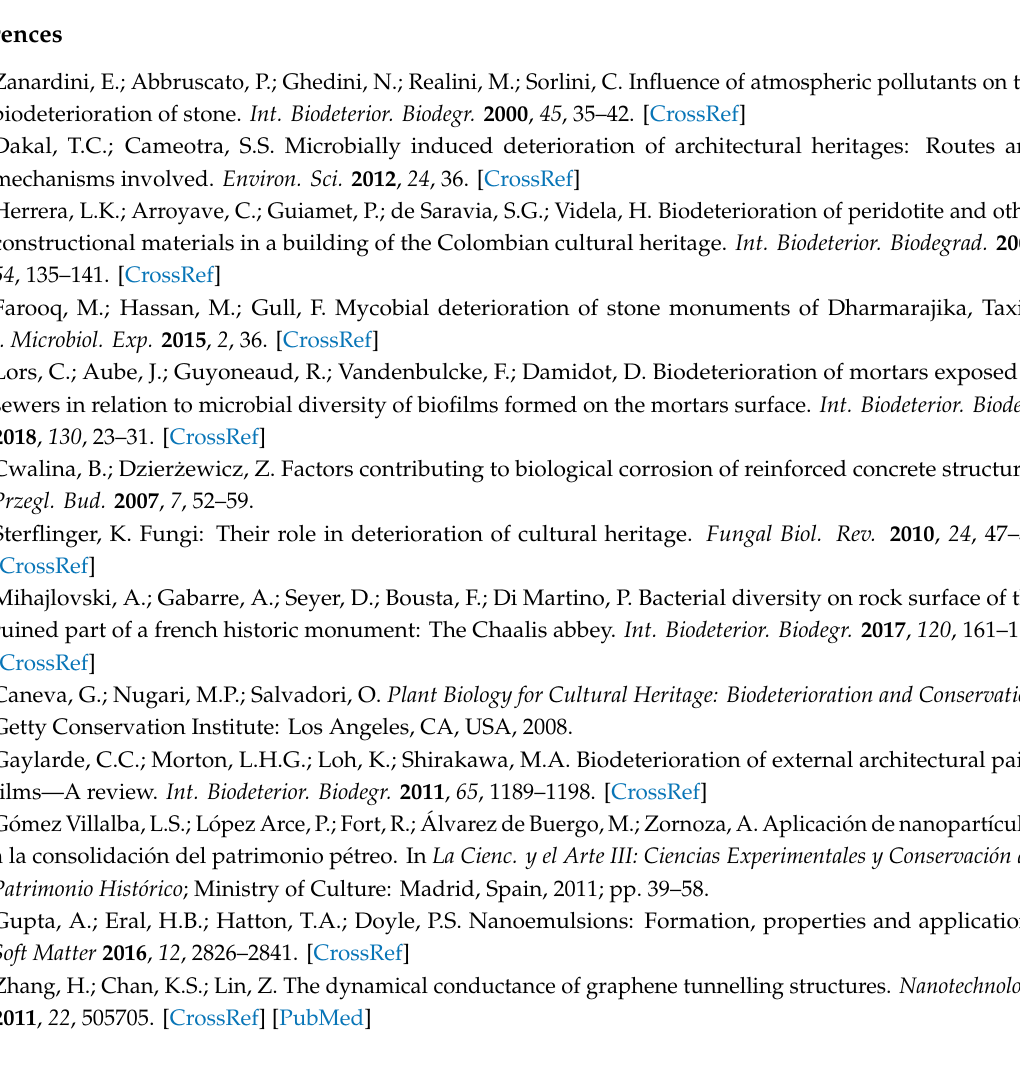
Figure S1: Cell viability after exposure to di ff erent concentrations of ZNGs, Figure S2: LIVE / DEAD staining after treatment with